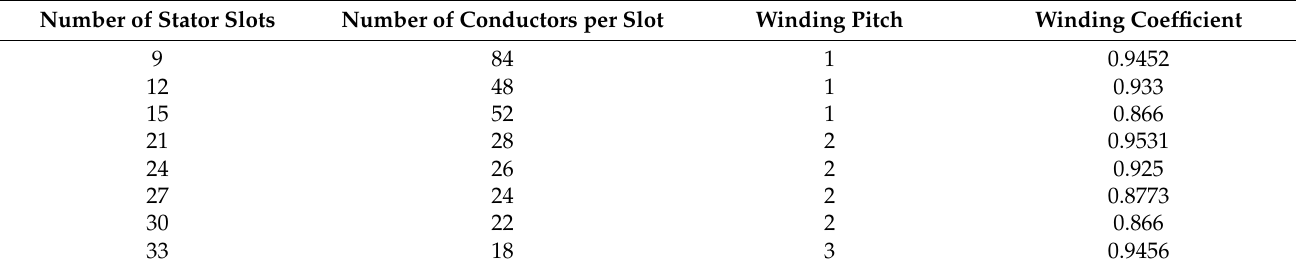
Table 4. Machine design schemes when the number of rotor poles is 10 and the number of stator slots takes different values. Number of Stator